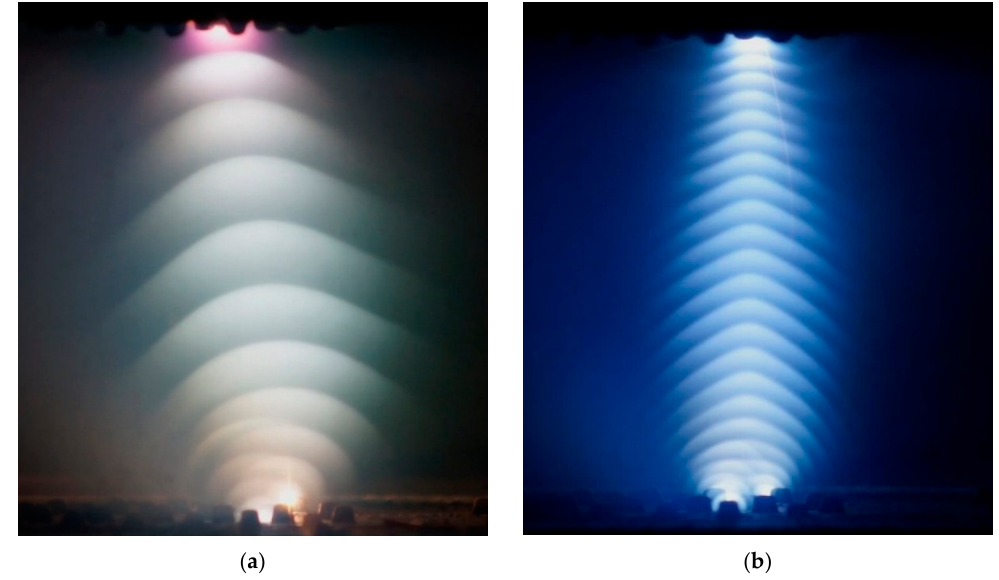
Figure 3. Examples of large-scale ( a ) and small-scale ( b ) strata of an ionization-unstable discharge.